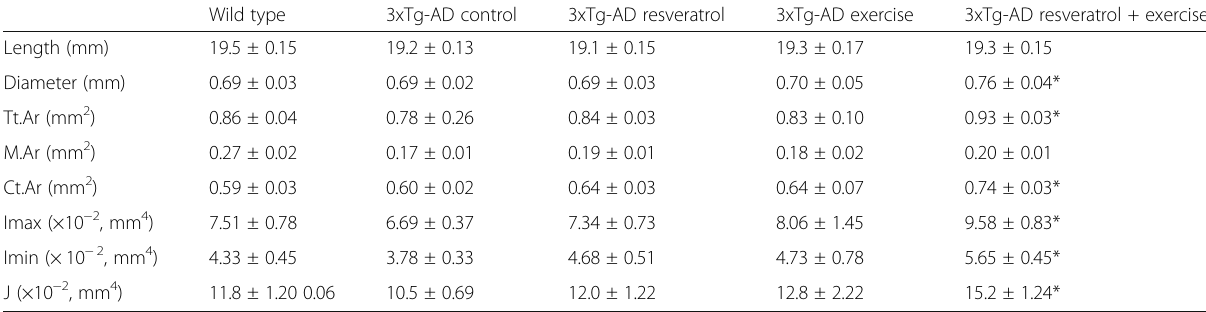
Table 1 Cross-sectional geometric properties of the tibia midshaft Wild type 3xTg-AD control 3xTg-AD resveratrol 3xTg-AD exercise 3xTg-AD resveratrol + exercise